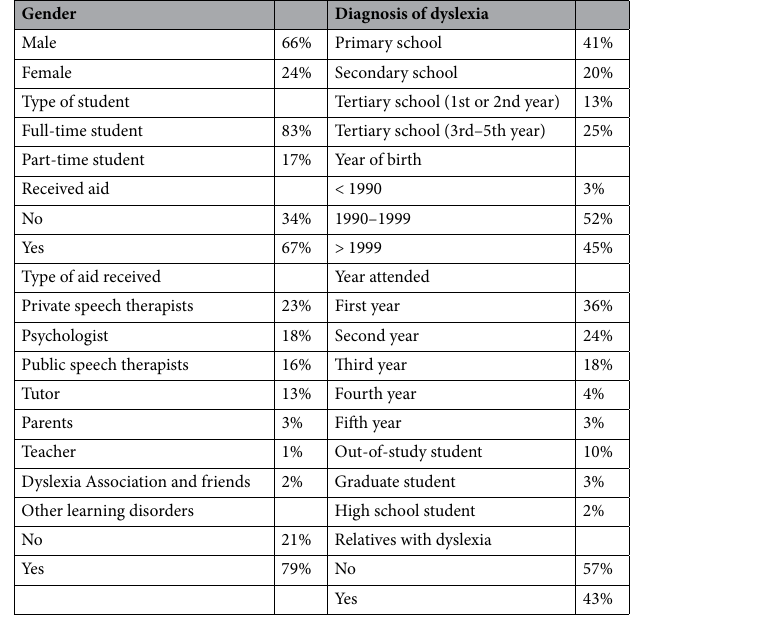
Table 1. Socio-demographic characteristics of the